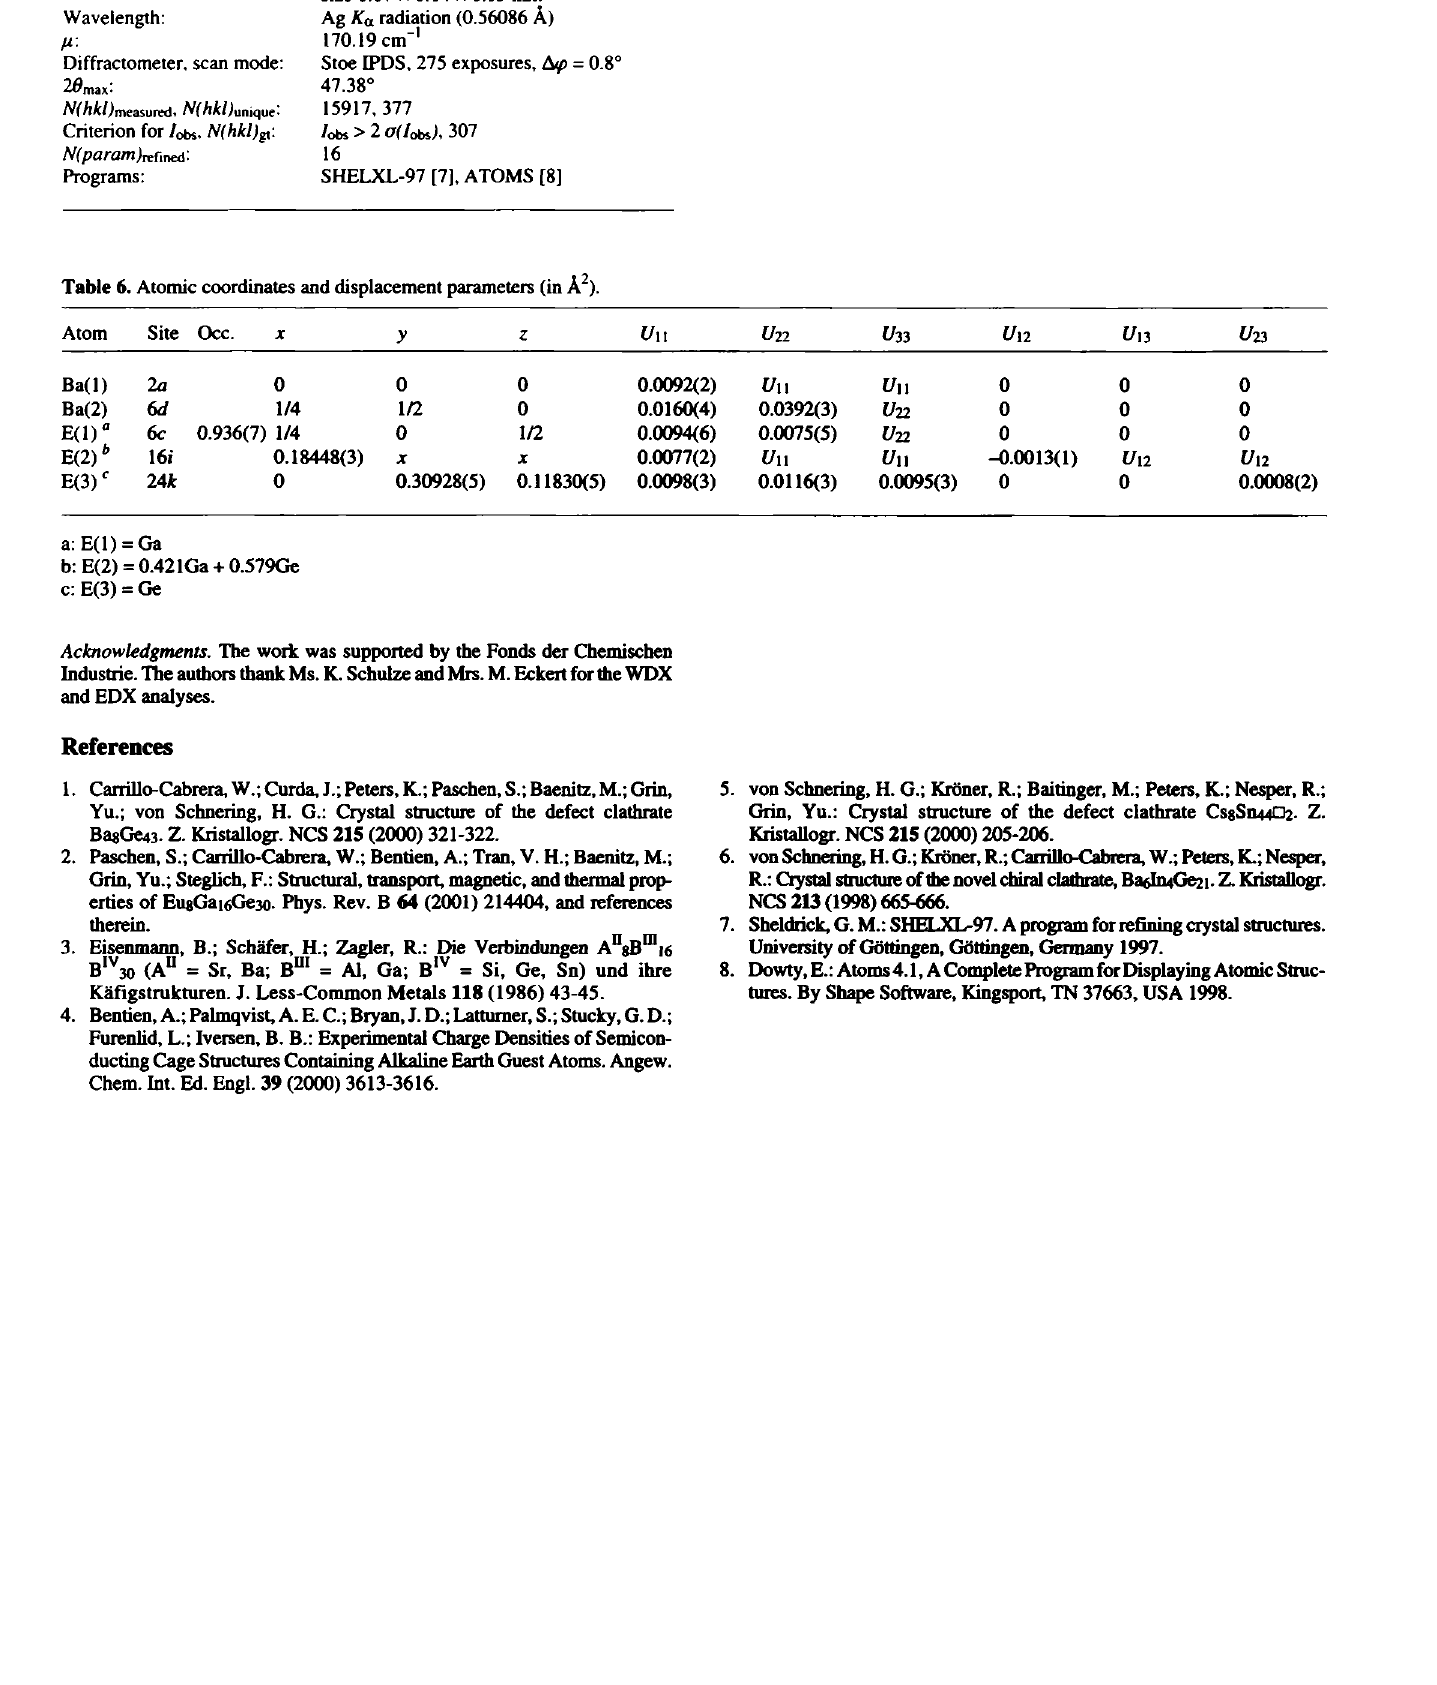
Table 6. Atomic coordinates and displacement parameters (in Â 2